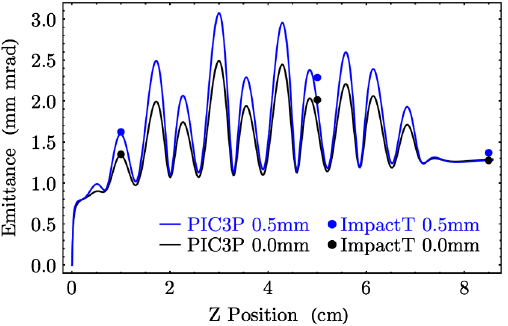
FIG. 11. Evolution of the transverse emittance along the X -band gun simulated with PIC3P and comparison with IMPACT- T at 3 sampled longitudinal points.